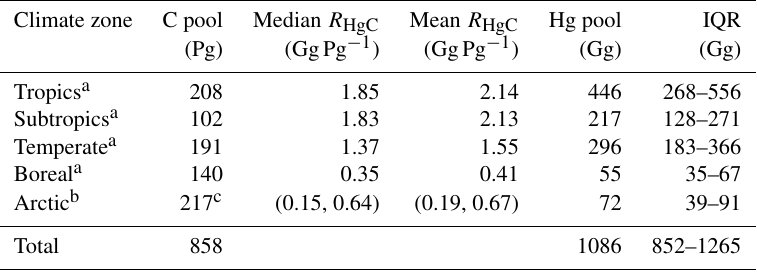
Table 4. Estimated soil Hg pool (0 to 30cm interval) for different climate zones based on reported R HgC and carbon pools. Hg pool uncertainties are reported as the interquartile range (IQR), i.e., the 25th to 75th percentiles of the Hg pool distribution estimates by a Monte Carlo